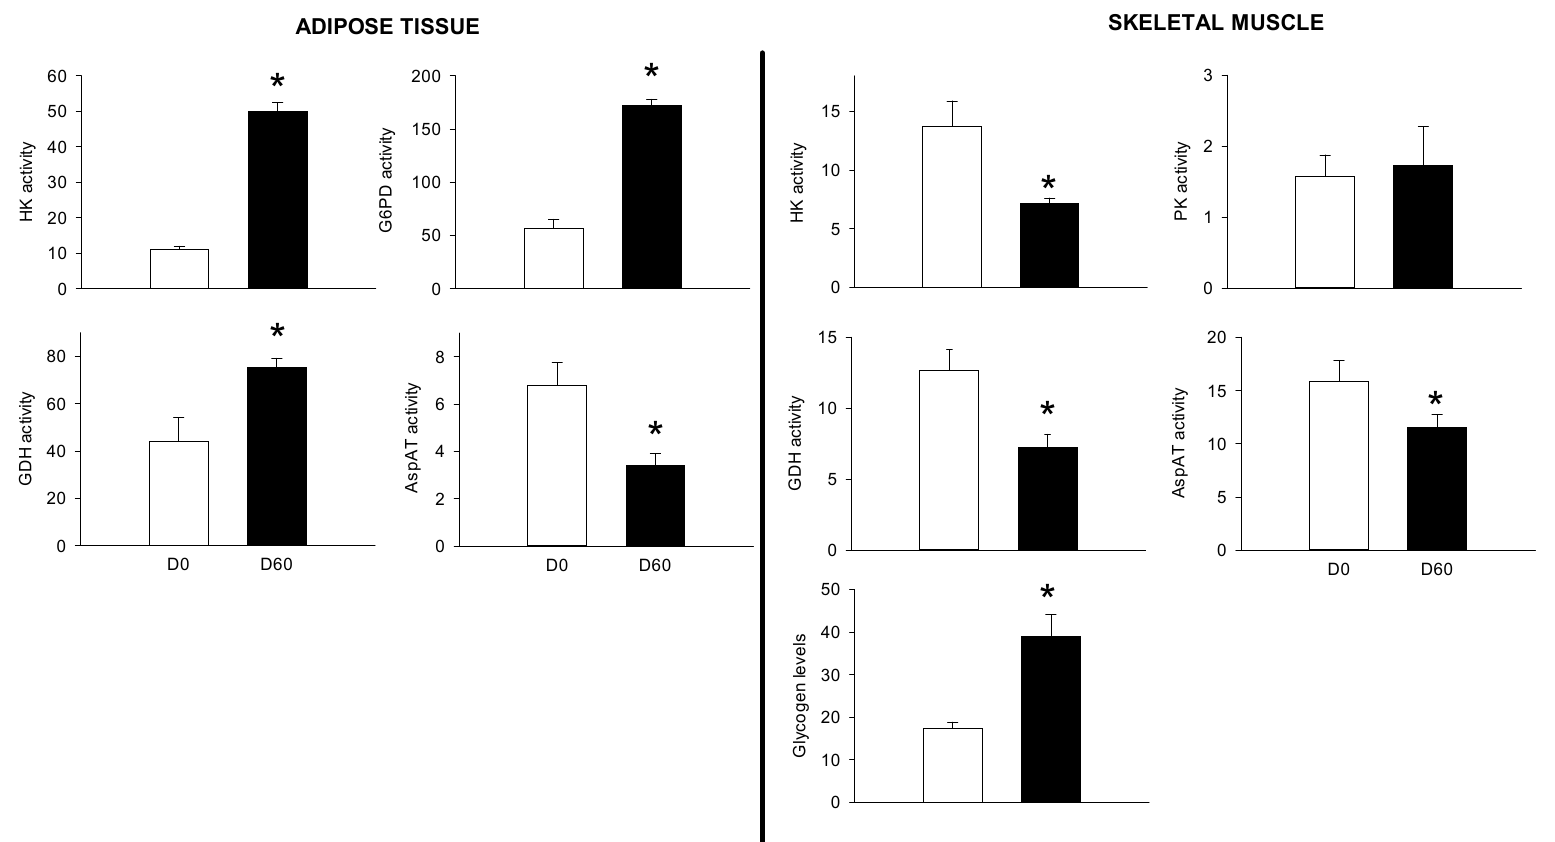
Figure 7. Glycogen levels, hexokinase (HK), pyruvate kinase (PK), glucose 6-phosphate dehydrogenase (G6PD), aspartate transaminase (AspAT), glutamate dehydrogenase (GDH) activities in adipose tissue and skeletal muscle samples from Yucatan mini-pigs fed a high fat–high sucrose (HFHS) diet for 2 months. Enzyme activity units (mU) are defined as nmol of substrate converted to product, per min, at 37 °C and per mg protein. Glycogen levels are expressed in μ mol of glycosyl units/g wet tissue. Results are expressed as means + SEM ( n = 5) and were analysed using a t -student test. *, significantly different from the D0 ( p < 0.05).